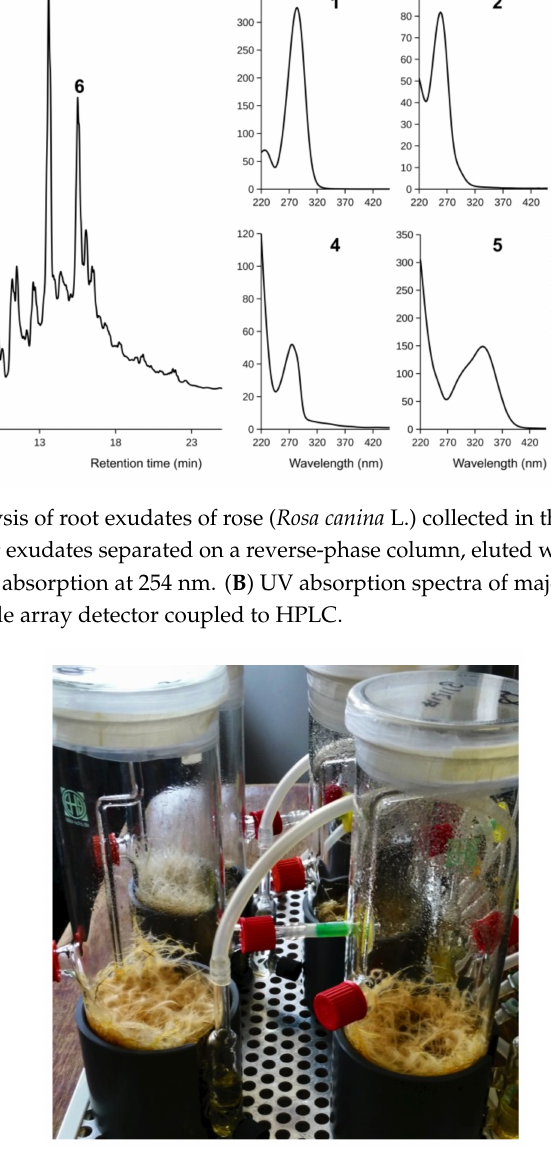
Figure 6. Hairy root cultures generated from several accessions of Hyoscyamus niger in bioreactors operated in a bubble aeration